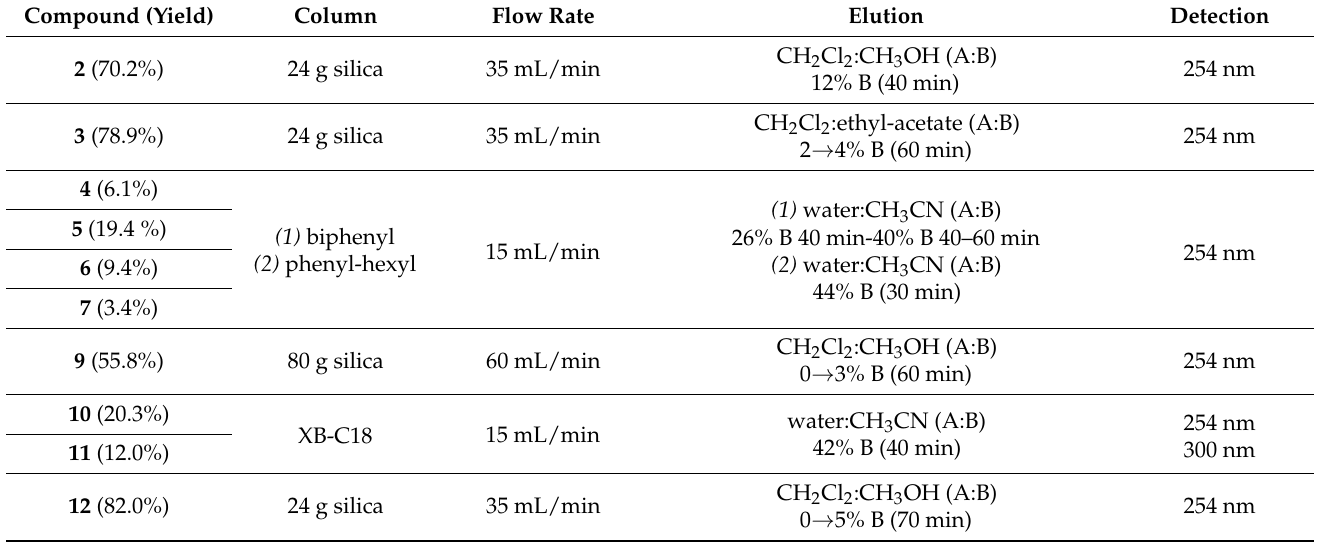
Table 5. HPLC and flash chromatographic methods used for the purification of the compounds. X g silica: “RediSep” flash chromatographic columns (TELEDYNE Isco, Lincoln, NE, USA). The following HPLC columns were used (each purchased from Phenomenex Inc., Torrance, CA,